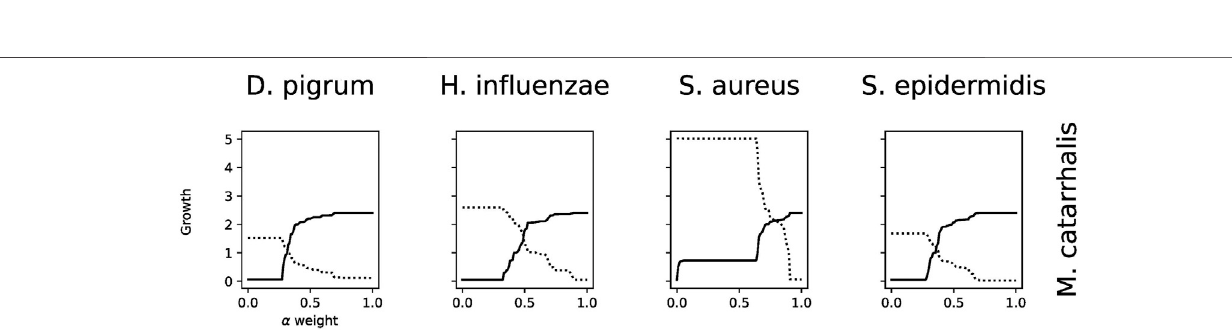
FIGURE 6 | Growth of each model, given the weight α . This shows, e.g., at which weight the community is balanced between two species. For instance, the pair- wise interaction between species Moraxella catarrhalis and Dolosigranulum pigrum , Haemophilus in fl uenzae , Staphylococcus aureus , and Staphylococcus epidermidis is